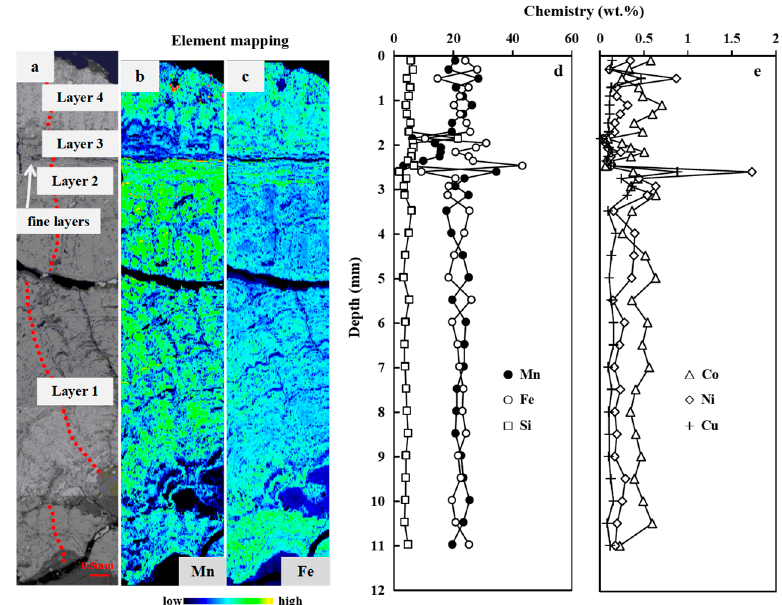
Figure 2. Microscopic investigations and depth profiles of element contents of FND-11. ( a ): BSE image; ( b , c ): X-ray Mn and Fe intensity maps; ( d , e ): Depth profiles of Mn, Fe, Si, Ni, Cu, and Co content. The red dashed line in ( a ) is the test line of EMPA.